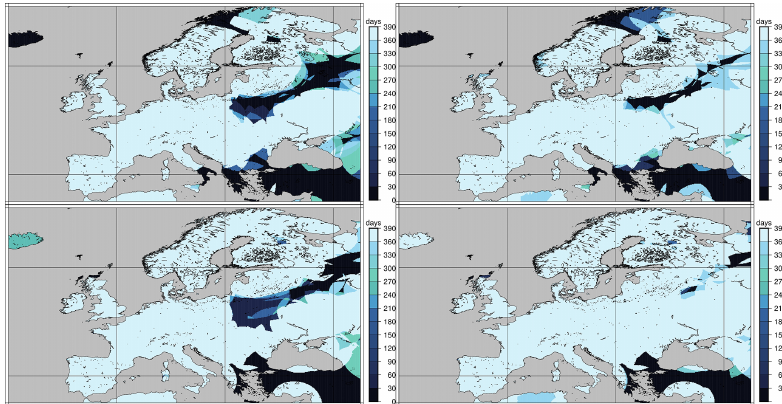
Figure A9. Maps indicating the number of days per year with available data for 1920 and 1921 and for temperature and precipitation.